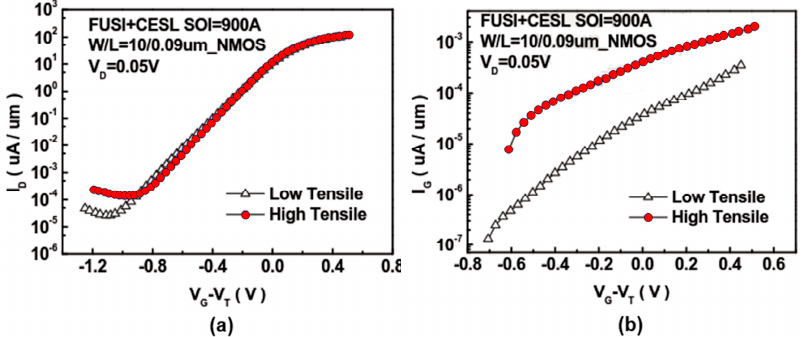
Figure 14. Comparison of I D and I G in NMOS non-conducting elements subjected to different layer strains: ( a ) I D – V G diagram and ( b ) I G – V G diagram [12].